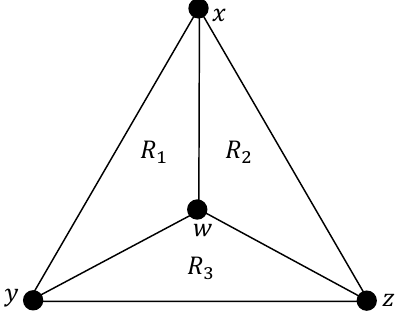
Figure 7: The structure of G which has only